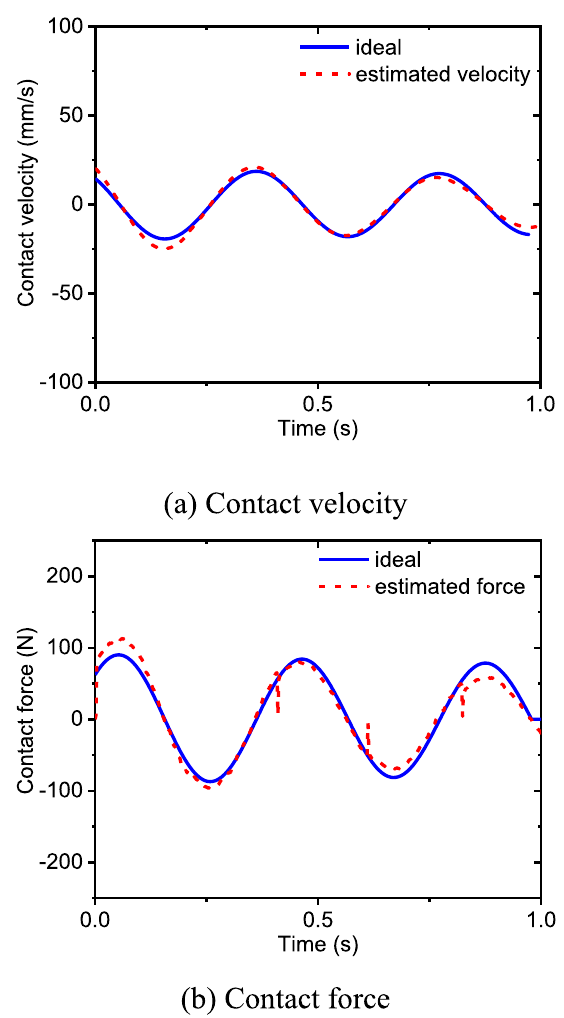
Figure 9 Contact velocity and force in virtual wall experiments